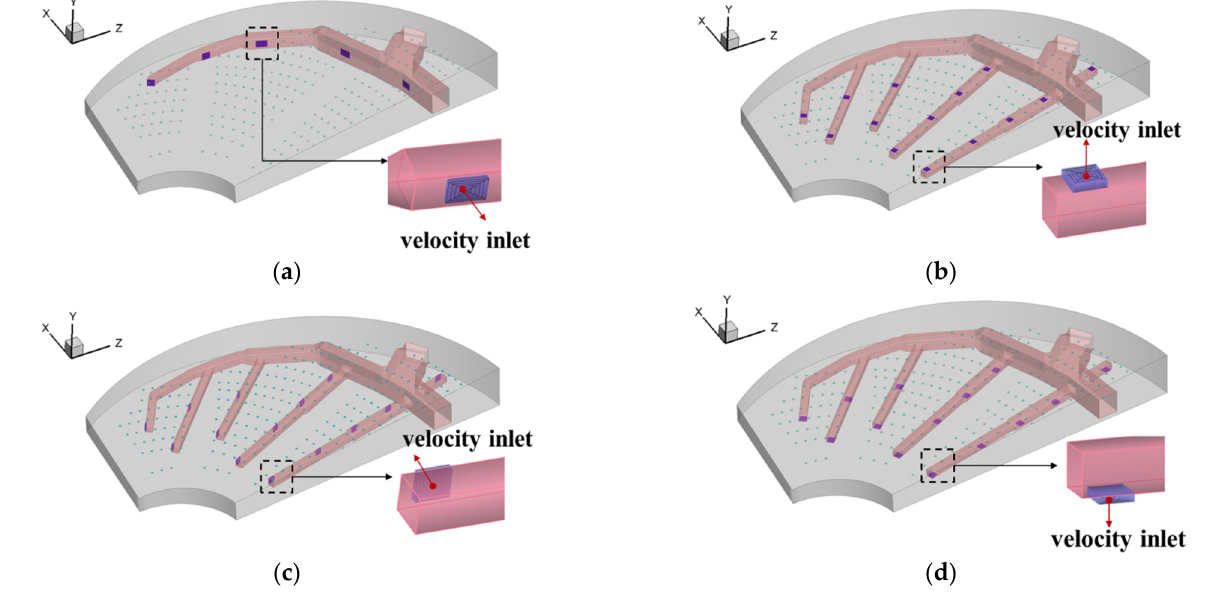
Figure 6. Different air supply models. ( a ) case A, ( b ) case B, ( c ) case C, ( d ) case D.